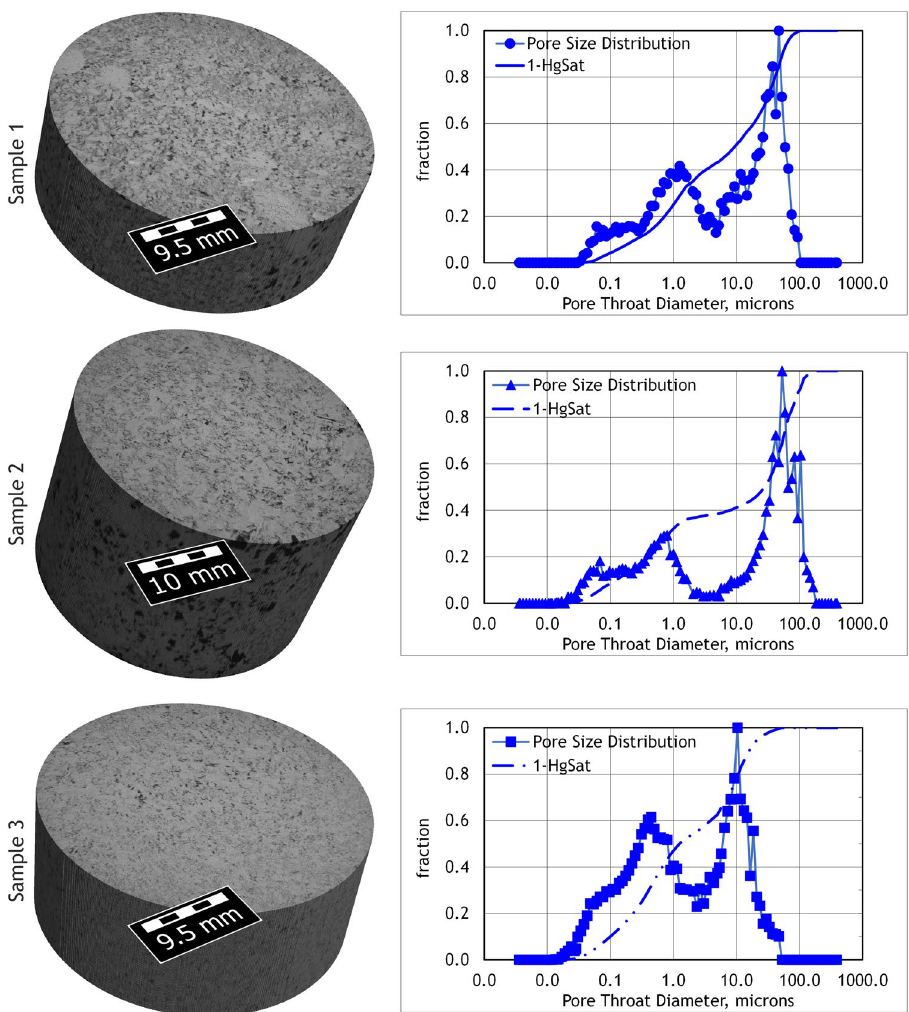
Figure 2. X-Ray CT Scan Renderings and MICP Pore Size Distributions. (left) CT scan renderings of the portions of each sample used for MICP analysis. Voxel size is 50 µm × 50 µm × 50 µm. The black to dark grey voxels are large pores and the light grey voxels contain matrix minerals and unresolved pores. (right) Normalized PSD and cumulative curves from